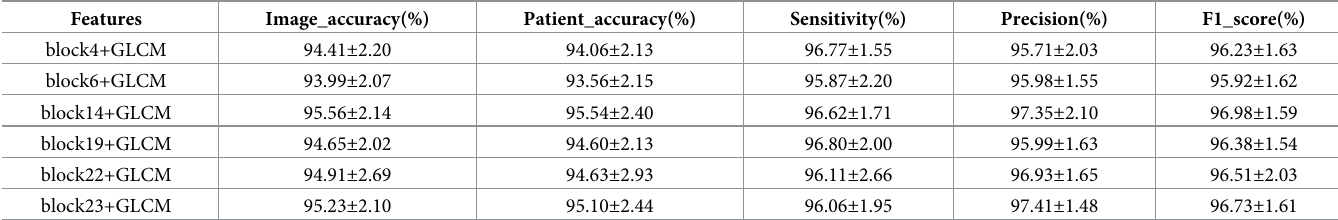
Table 5. MIB classification performance of fused features.